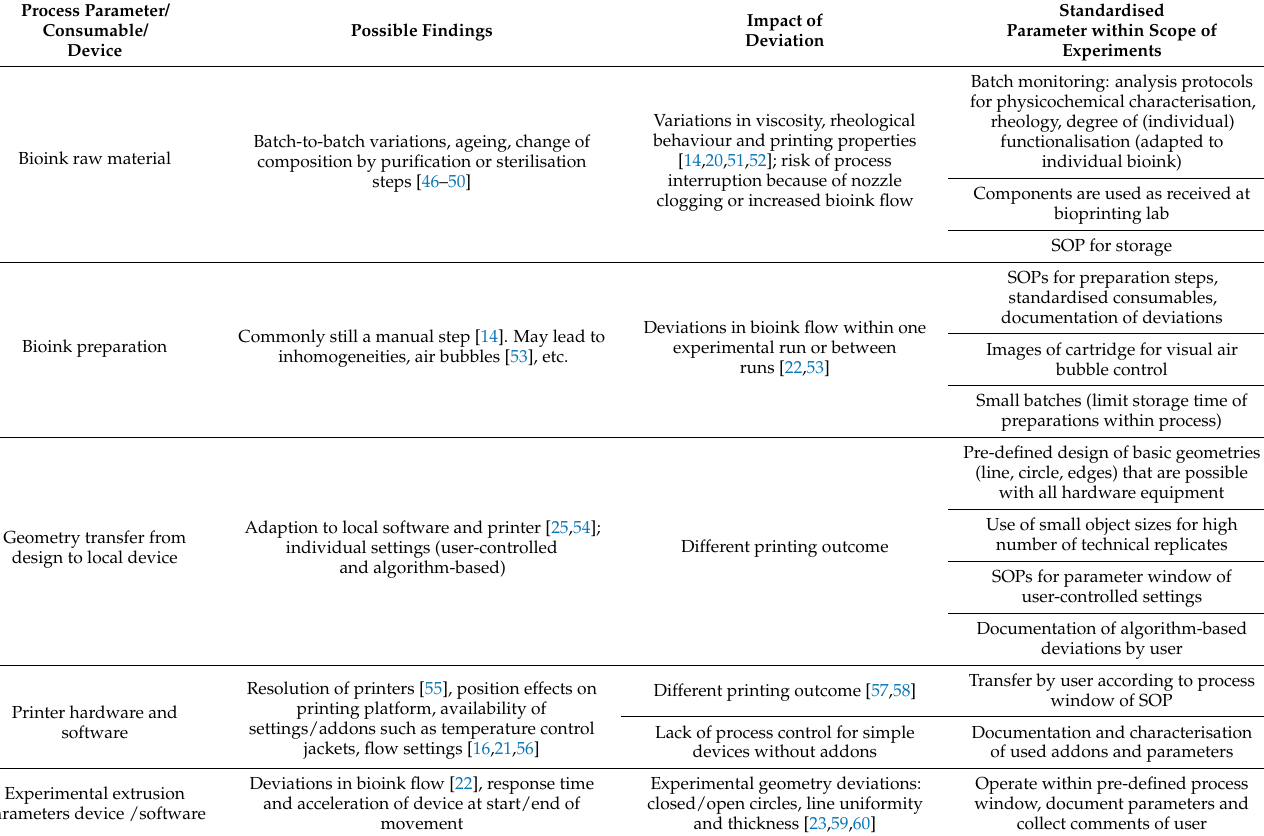
Table 1. Risk assessment for the process steps of the round robin test. Based on literature research, actions for standardisation and quality control within the scope of the experiments were